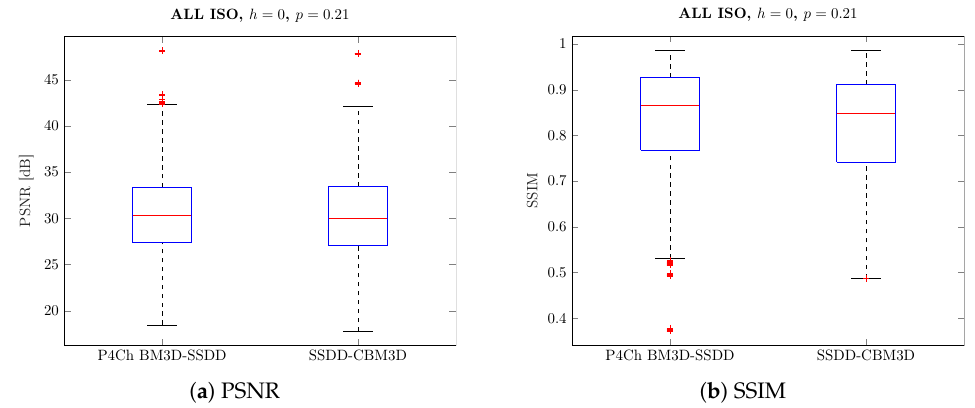
Figure 18. Pairwise comparison of different filtering approaches—full image